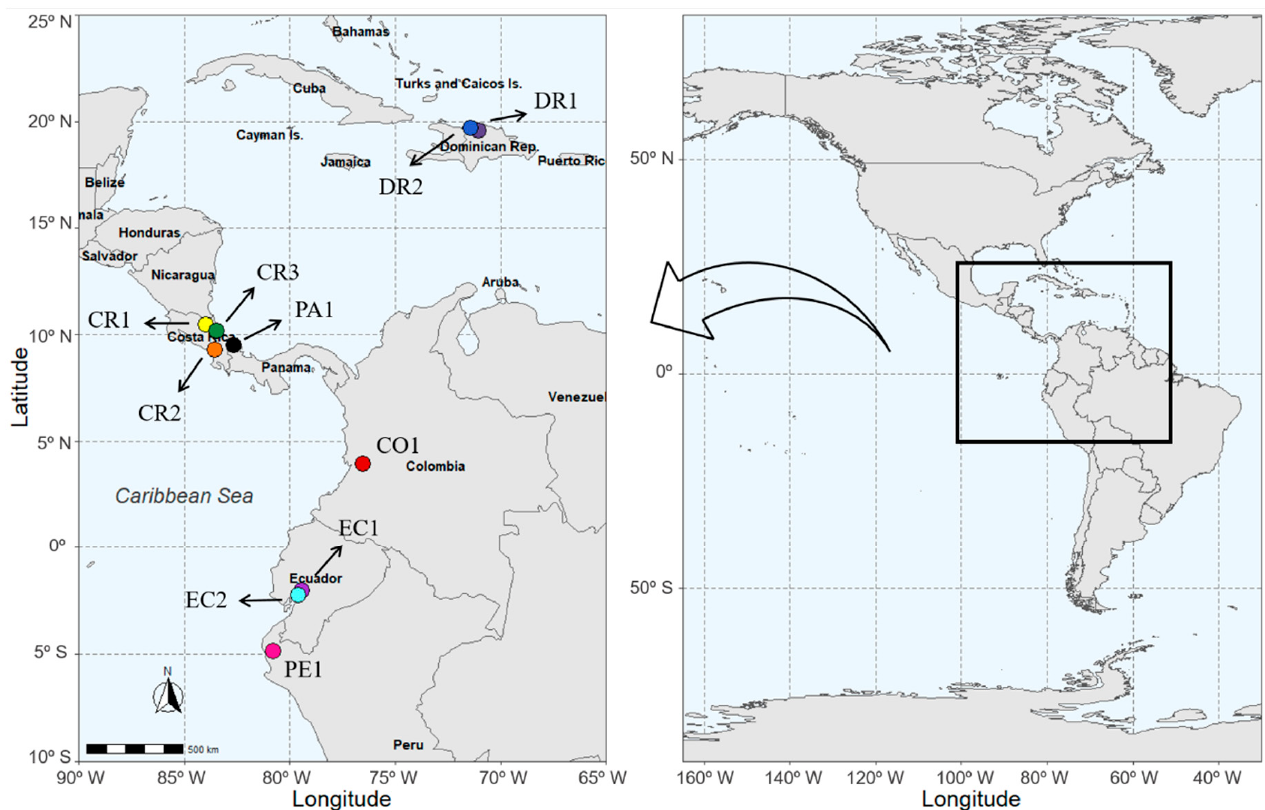
Figure 1. The sampling sites of the collected bananas. CO: Colombia; CR: Costa Rica; DR: Dominican Republic; EC: Ecuador; PA: Panama; PE: Peru; the numbers refer to the individual farms in a specific country.